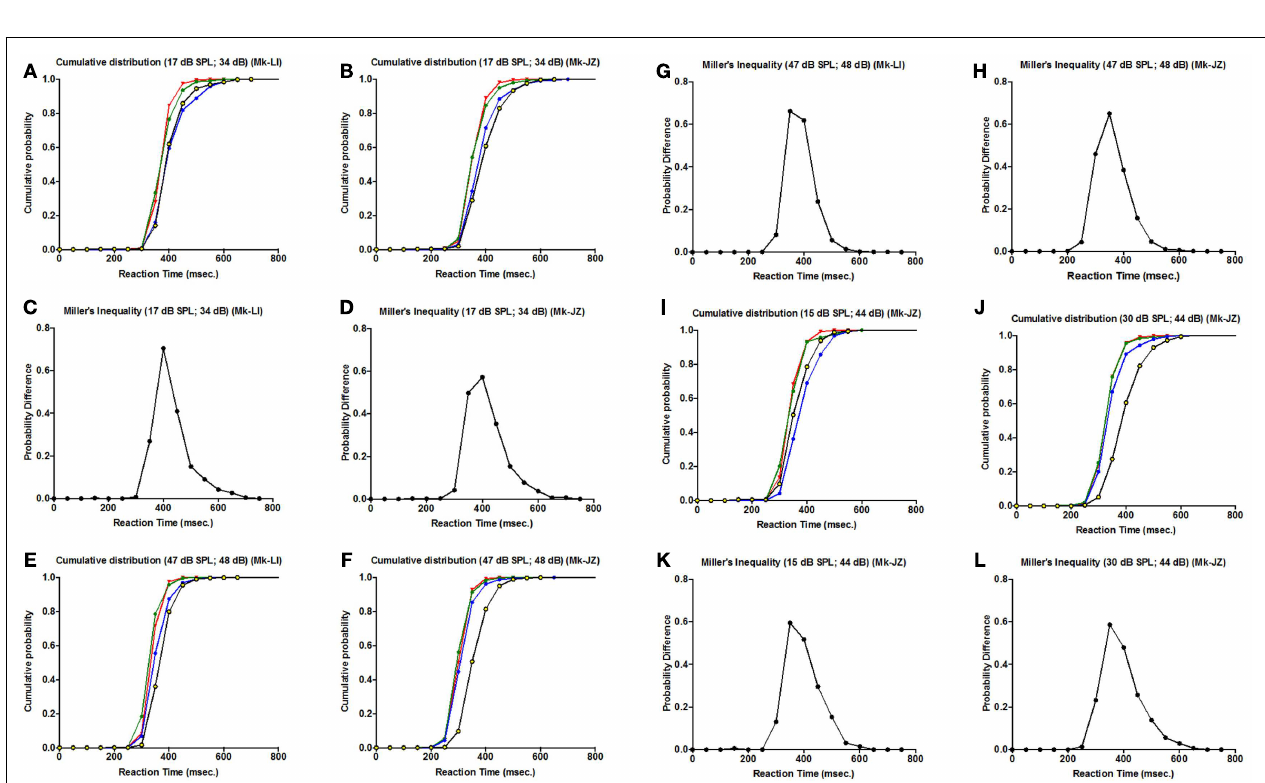
cumulative distribution graphics, the blue curve represent the auditory condition, the yellow/black curve the visual condition and the green curve the visuo-acoustic condition.The red curve is the model predicted by Miller’s race model inequality (Miller,